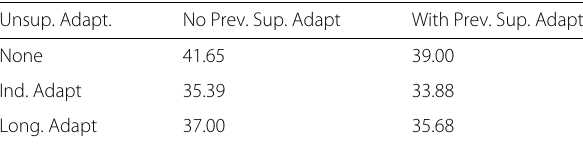
adaptations of configuration: none, independent, or longitudinal unsupervised adaptation and with or without previous supervised adaptation Unsup.